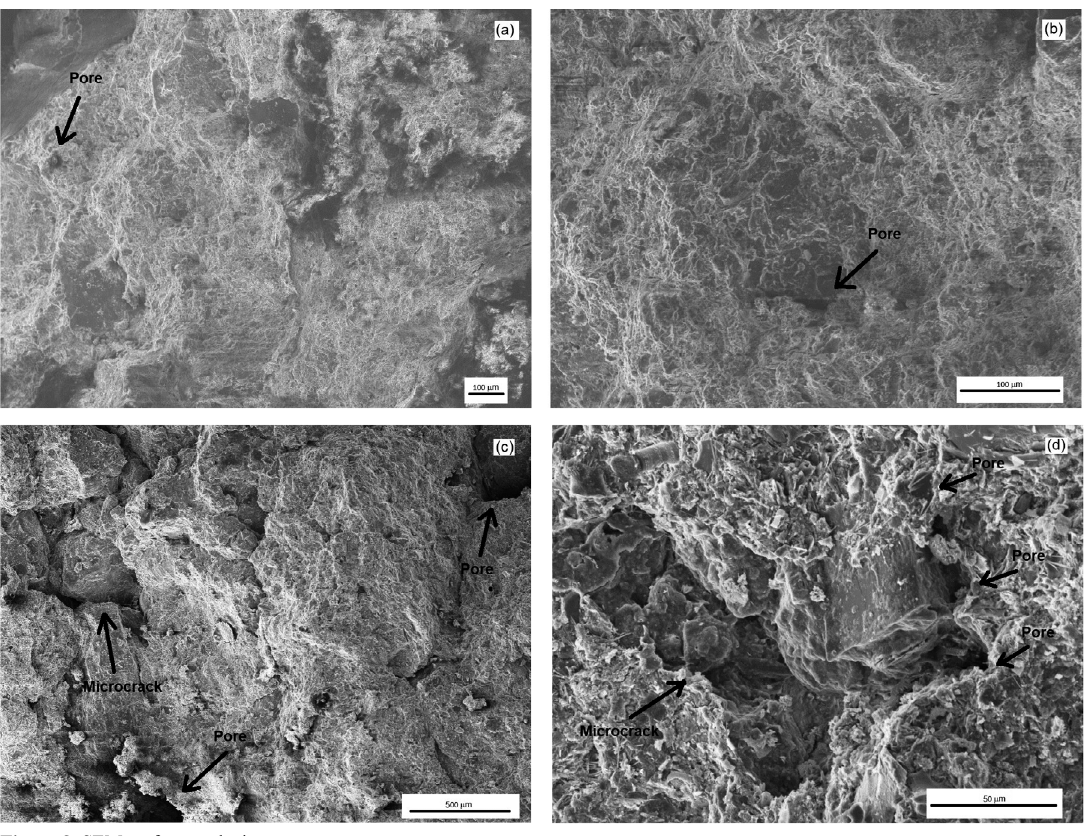
Figure 8. SEM surface analysis